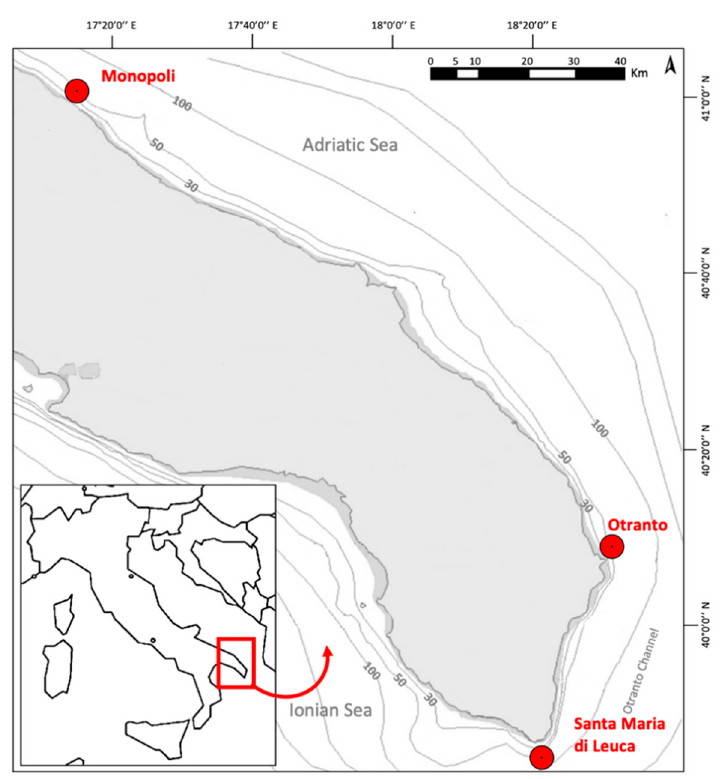
Figure 1. Location of the three areas under study off the Southeastern Italian coast (Apulia). Monopoli site (MON) is the northernmost and located approximately 1.5 nautical miles off the coast in the Southern Adriatic Sea. At this site the bioconstruction is up to 2 m in thickness and occurs in a depth range between 30 and 55 m, along a fault line with NW-SE orientation. The bioconstruction is characterized by two species of non-symbiotic scleractinians Phyllangia americana mouchezii (Lacaze–Duthiers, 1897) and Polycyathus muellerae (Abel, 1959) as primary bioconstructors. The site of Otranto